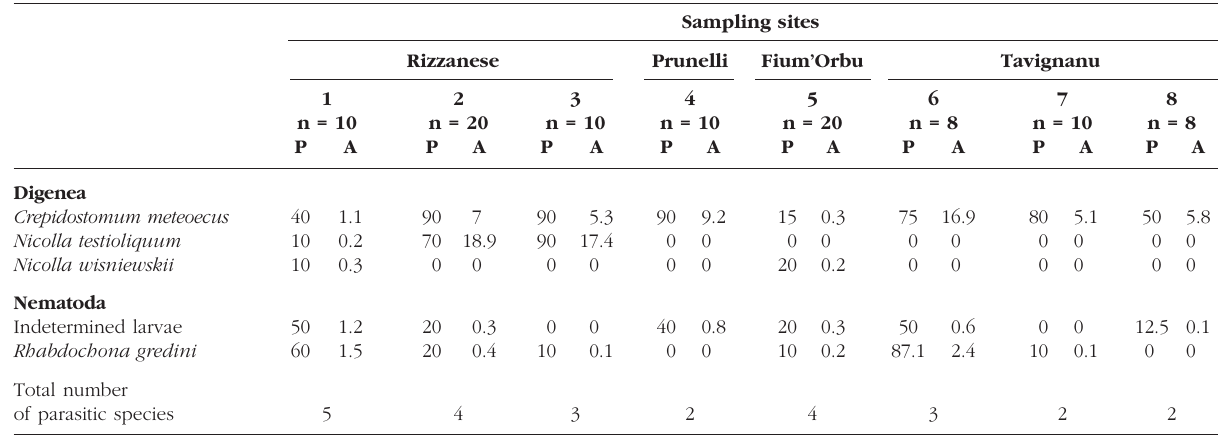
Fig. 1. – Map of Corsica island: sites where the brown trouts were collected.